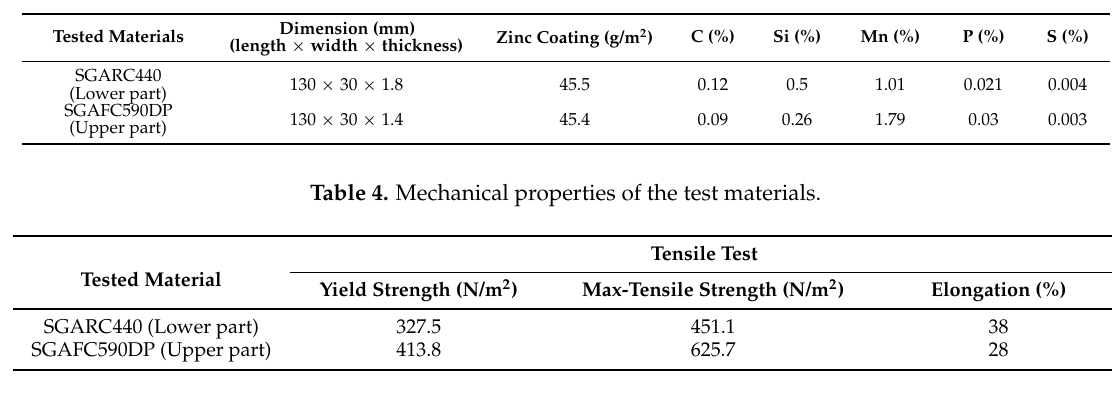
Table 3. Chemical composition (weight %) of the test materials.